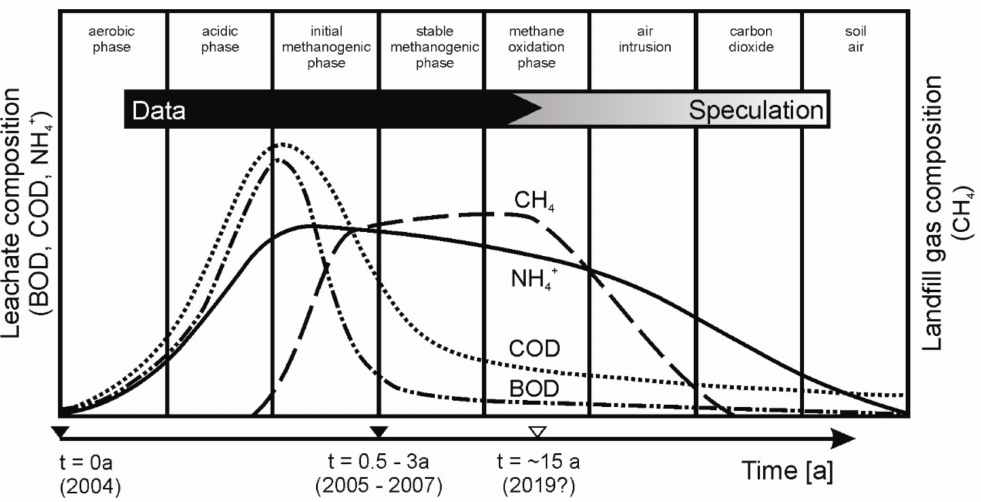
Figure 1. Evolution of landfill leachate and gas composition (modified from